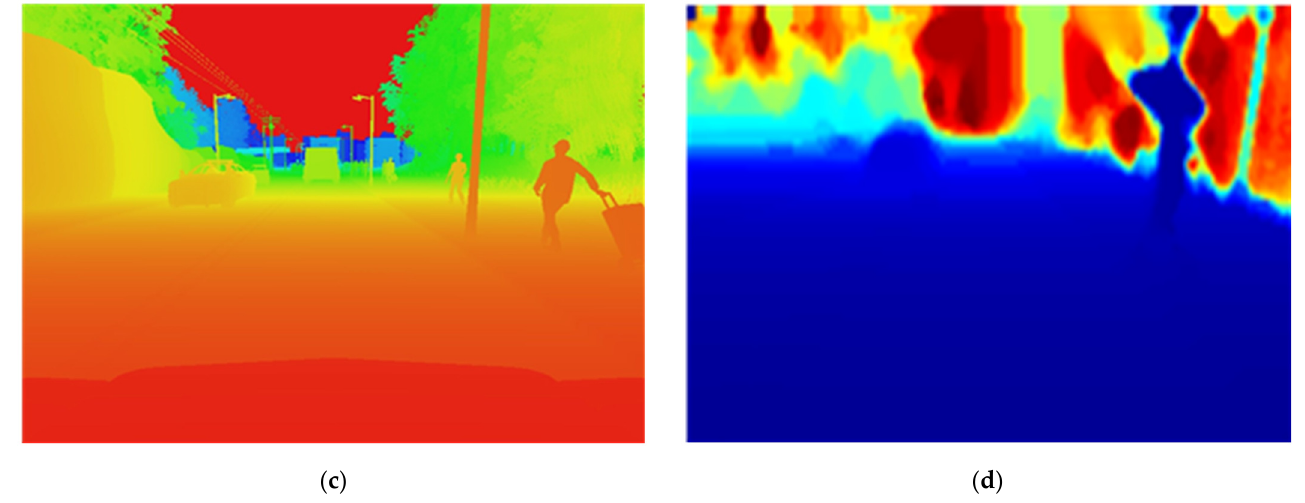
Figure 5. Images utilized in our proposed model. ( a ) Input RGB image, ( b ) Semantic Segmentation Ground Truth, ( c ) CARLA depth ground truth, ( d ) Post-processed image of an active depth.